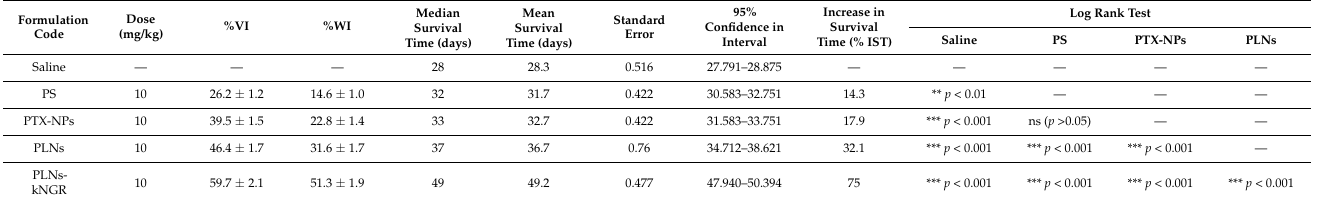
Table 3. The effect of free PTX drug and PTX-loaded PLNs on tumor volume growth inhibition (%VI), tumor weight growth percentage inhibition (%WI), and survival time of different treatments on growth against HT-1080 tumors in Balb c/mice at the end of therapy. ns = not significant, ** p < 0.01, *** p <